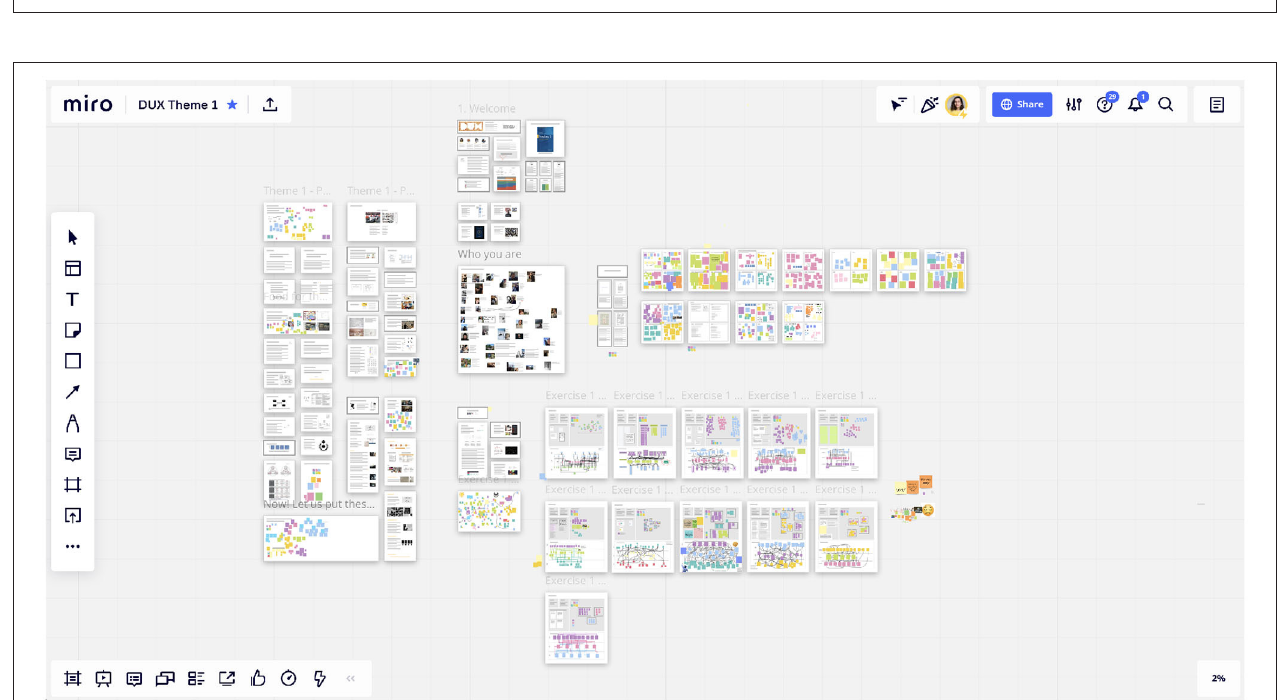
FIGURE 4 | A screenshot of an empty Miro board showing (A) on top, a number of slides introducing the course, (B) to the left, slides used as an introductory lecture, (C) an empty central slide where students can present themselves, (D) to the right, a set of empty boxes for literature seminar groups, and (E) toward the bottom, structured boxes with instructions for the exercise associated with the theme. We developed custom boards for each of the themes open to the students to edit and consult at any time throughout the course. The aim of this figure is not for the content to be readable, but rather to show the structure and general feeling of an empty board, particularly when compared to when the board is populated as seen in Figure 5 .